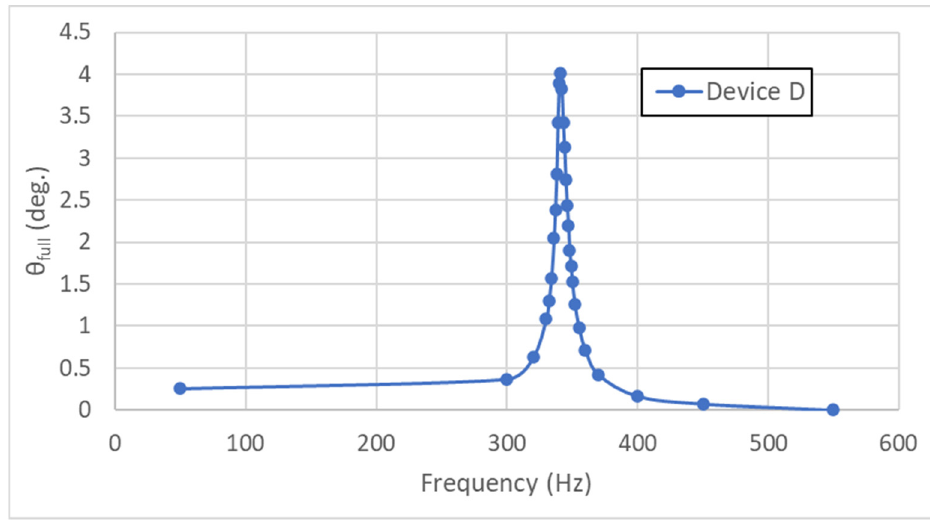
Figure 7. The frequency response of Device D.